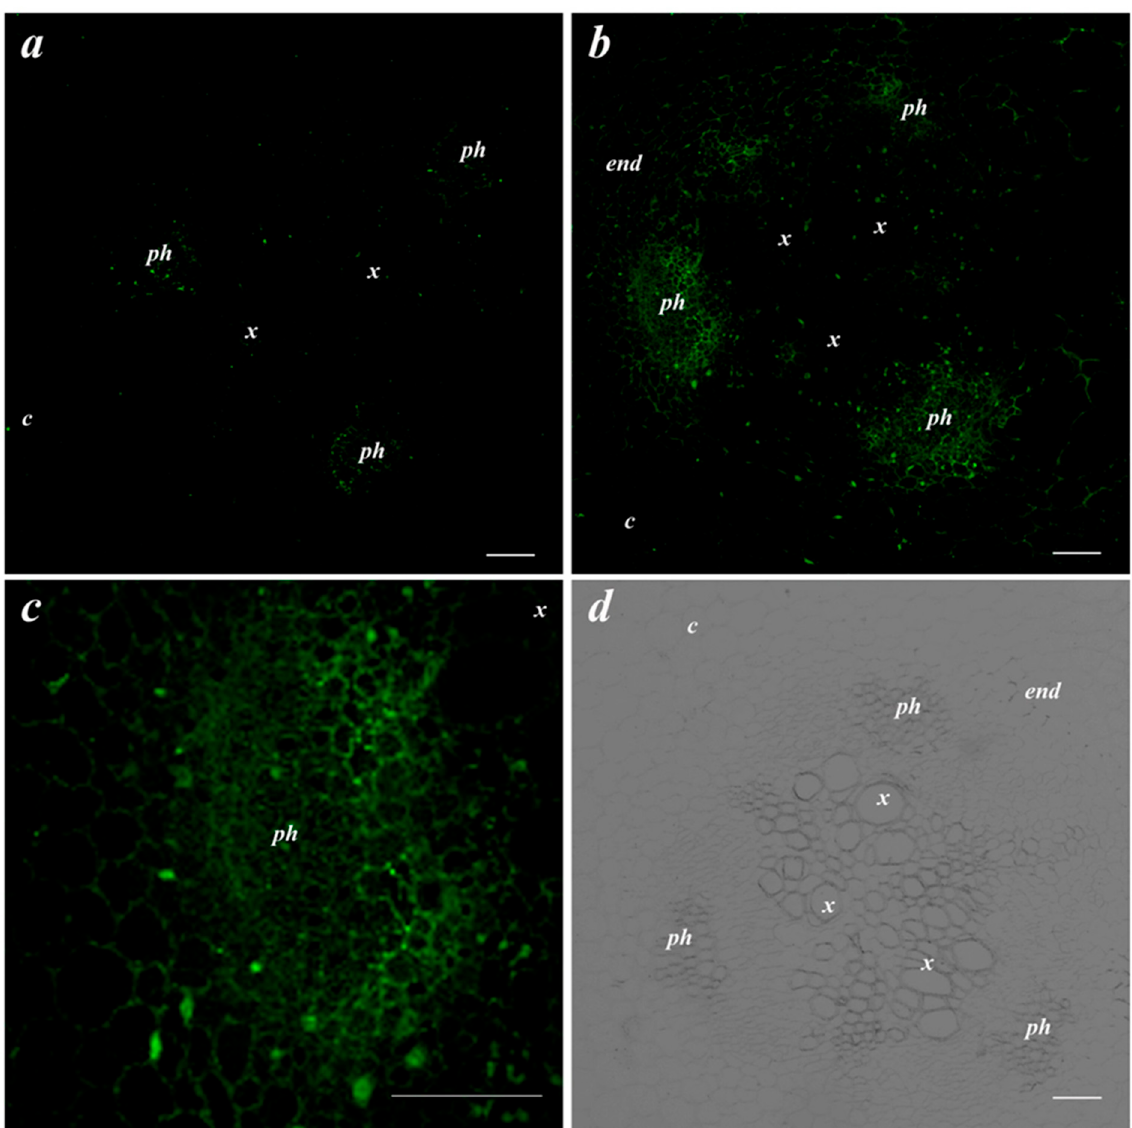
Figure 2. Effects of bacterial inoculation on LTP localization in the central cylinder of the basal part of the root. Root cross-section of uninoculated pea plants ( a ) and plants inoculated with Pseudomonas mandelii IB-Ki14 ( b ). A higher magnification image of the phloem cells from figure b ( c ). The bright field image of the central cylinder of the root ( d ). The scale bar is 50 µ m. end —endodermis; x —xylem; ph —phloem; c —cortex.